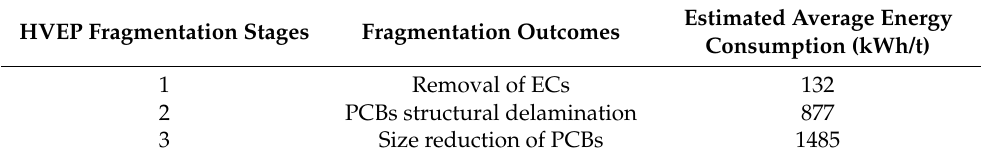
Table 2. Energy consumption for different HVEP fragmentation stages [89]. HVEP Fragmentation